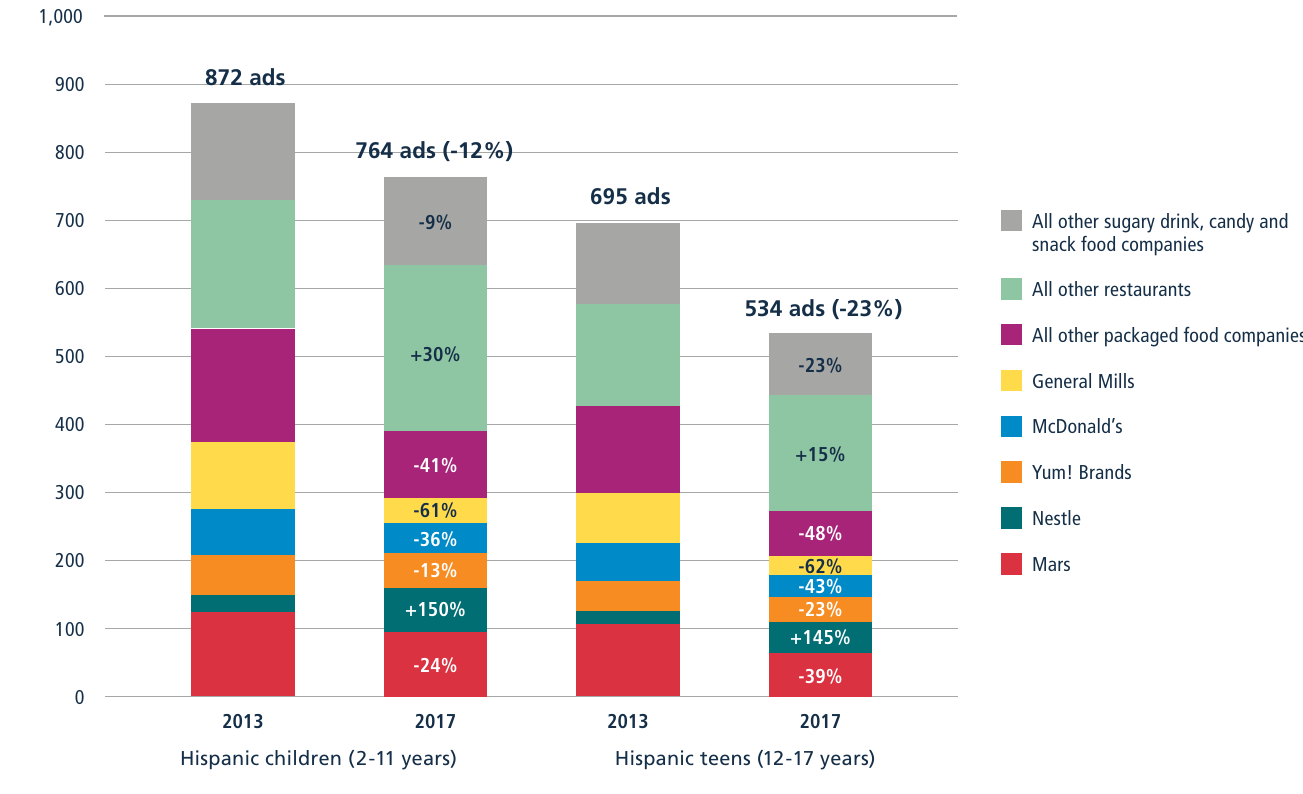
FIGURE 8. CHANGES IN HISPANIC YOUTH EXPOSURE TO ADVERTISING ON SPANISH-LANGUAGE TV BY COMPANY